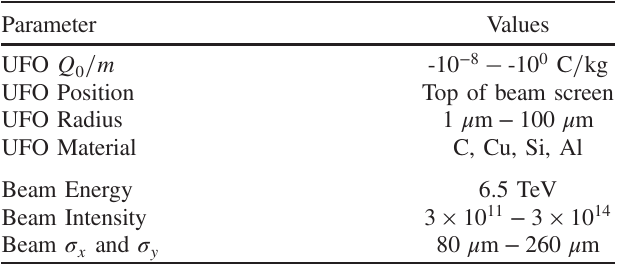
TABLE II. Input parameters for Monte-Carlo simulations.